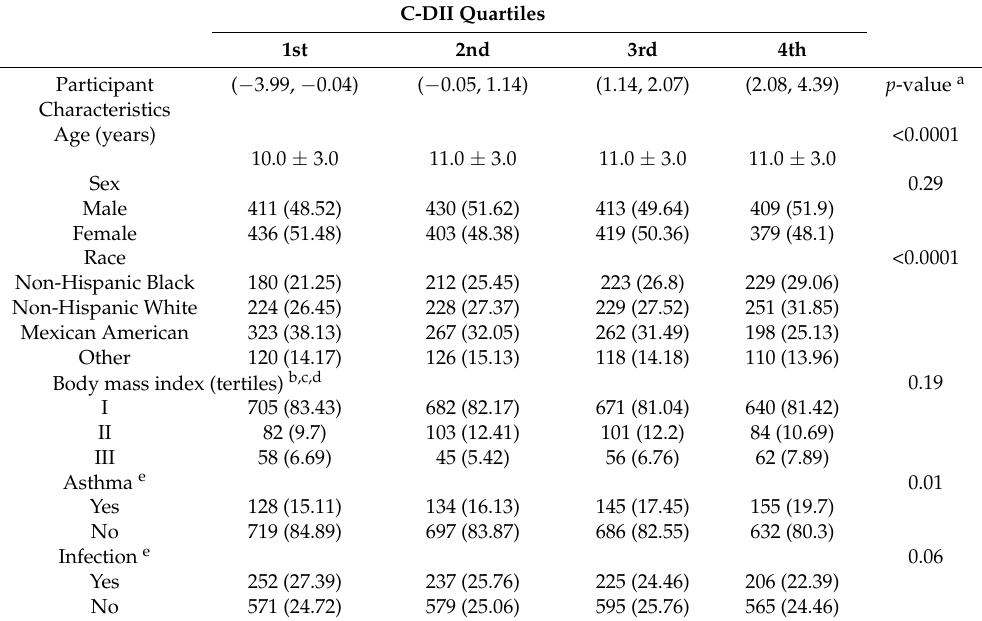
Table 1. Participants’ characteristics across quartiles of the children’s dietary inflammatory index (C-DII) among 3300 children. NHANES,